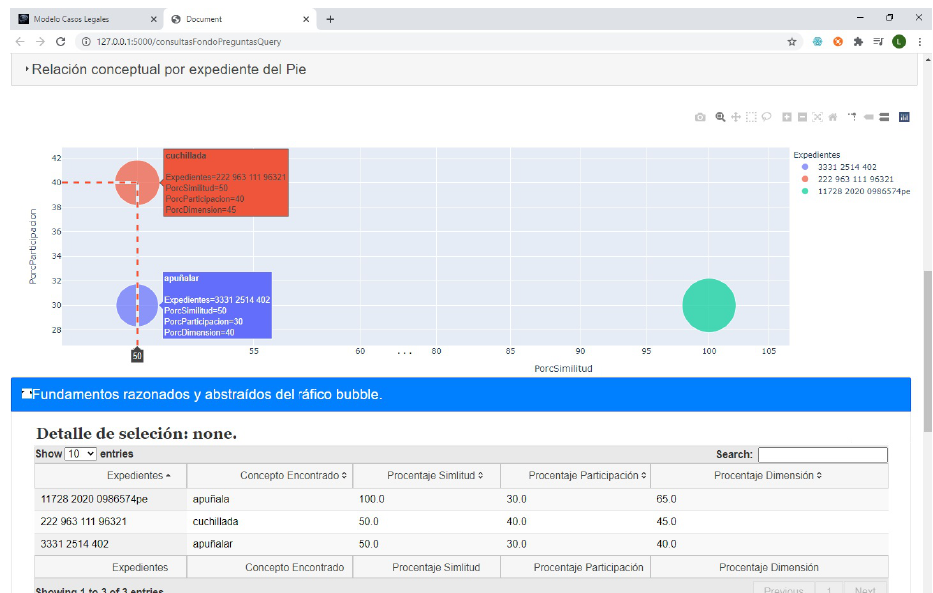
Figure 12. EGI explains employing circles, size, and colors to the user the set of legal files containing the factual picture and similar scenarios to the legal context with which the judge works. The machine explains that each circle is a set of legal files with characteristics and states. The machine recommends those that are higher and to the right of the graph. The judge can explore, analyze, and select other circles that consider the best for a specific legal